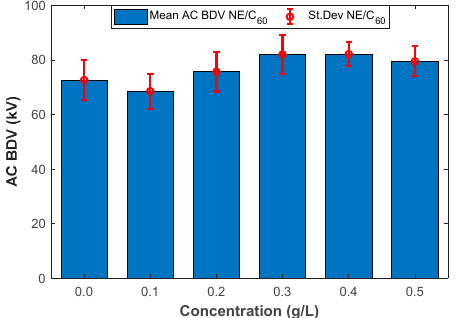
Figure 1. Mean breakdown voltages versus fullerene (C 60 ) concentrations.